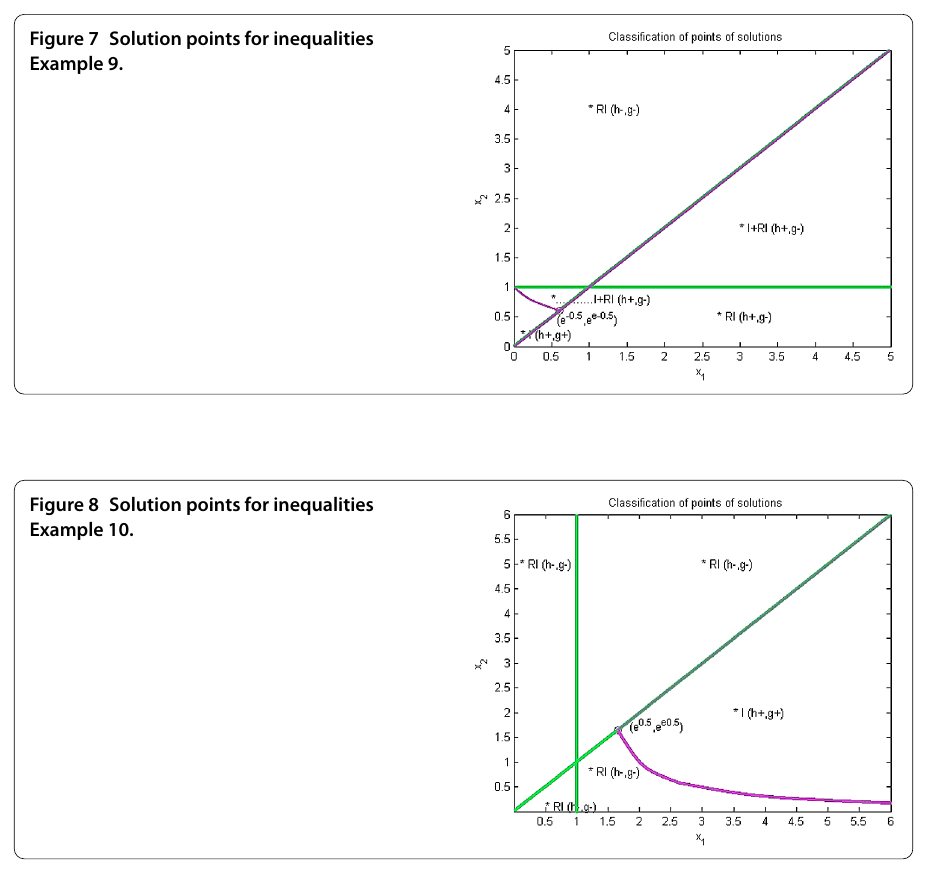
Figure 7 Solution points for inequalities Example 9.